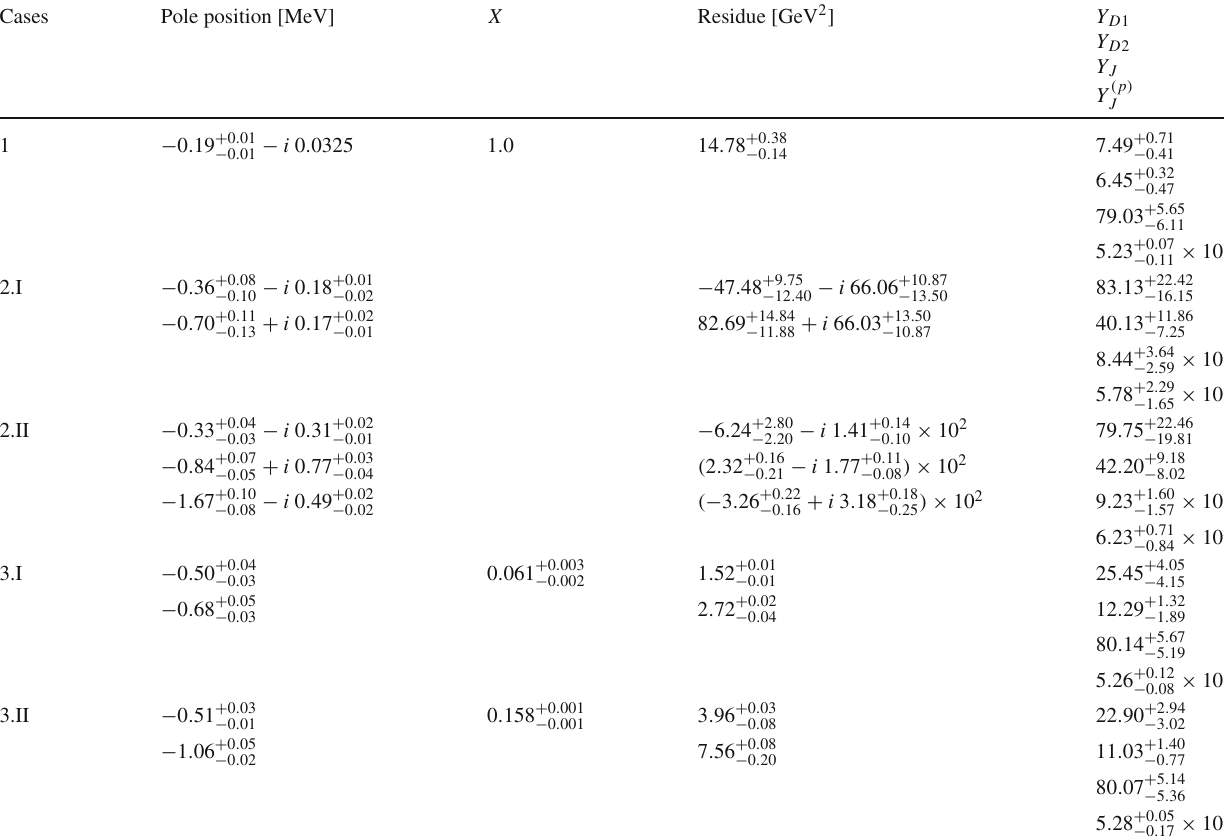
Table 2 Summary of the combined fits in Sect. 6 for all the cases. From left to right, the pole positions, compositeness ( X ), residue and yields ( Y ) are given. Y D 1 , Y D 2 denote the yields corresponding to the BaBar and Belle data on the D 0 ¯ D ∗ 0 mode, respectively; Y J denotes the one